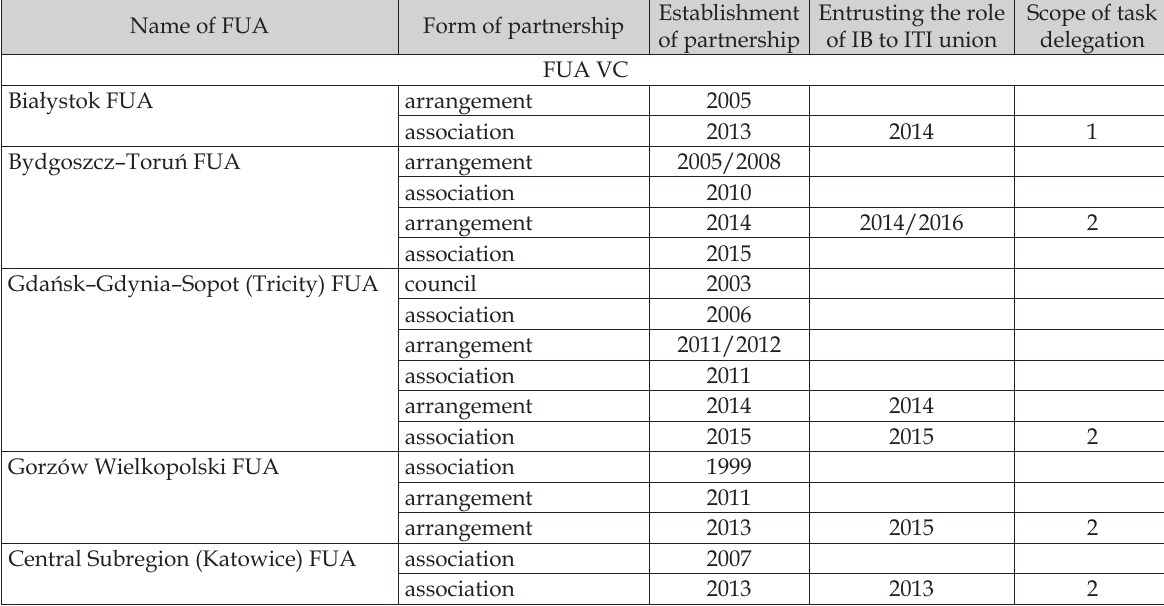
Table 4. Legal and organisational forms of cooperation of LGUs and institutionalisation of ITI unions in select